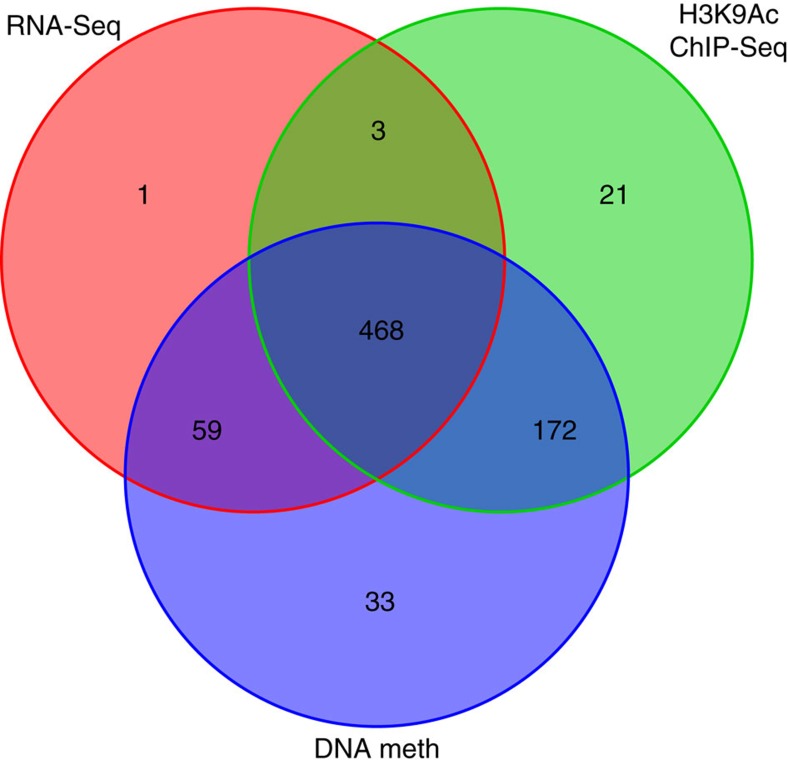
Subsets of samples with RNA-seq H3K9Ac and DNA methylation data.Number of participants with RNA-seq, H3K9Ac ChIP-seq or DNA methylation data available, or combinations of the 3.